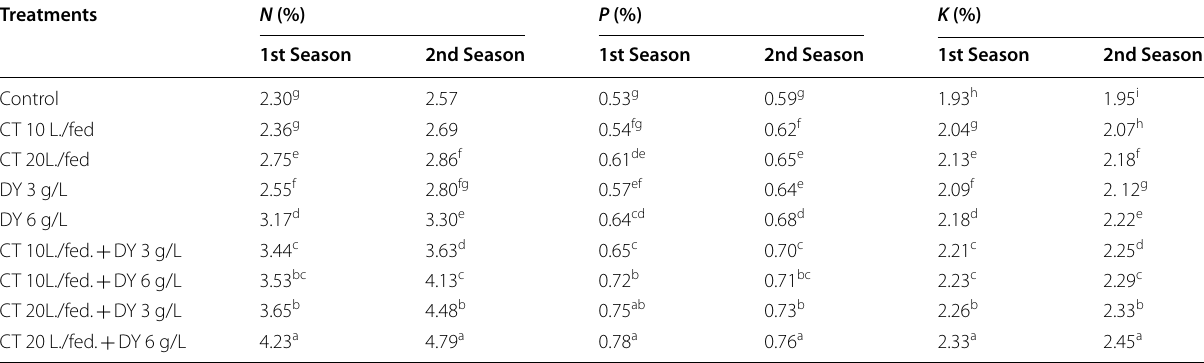
Table 9 Effect of compost tea, dry yeast and their mixture on leaf mineral contents (N, P, and K %) of sweet pepper during 2018/2019 Treatments